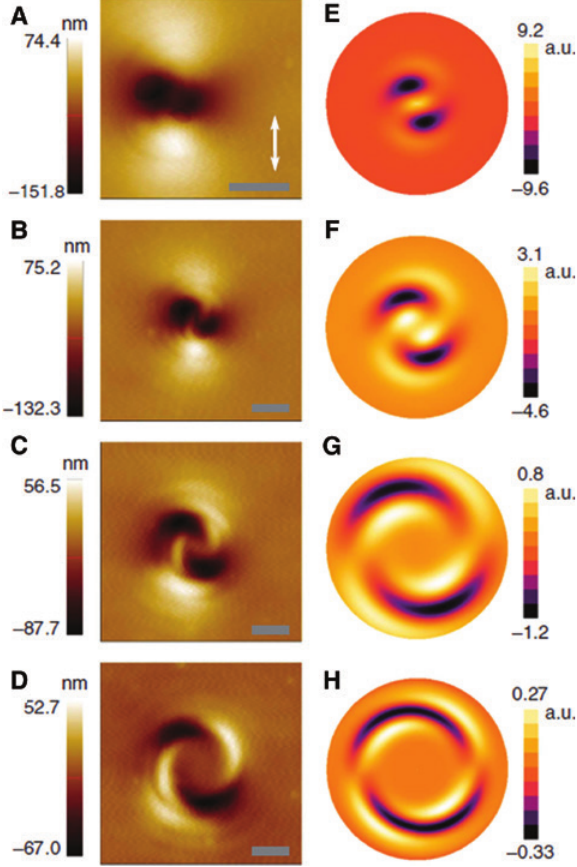
Figure 8: The spiral surface reliefs predicted by the phenomeno- logical model proposed in Ref.